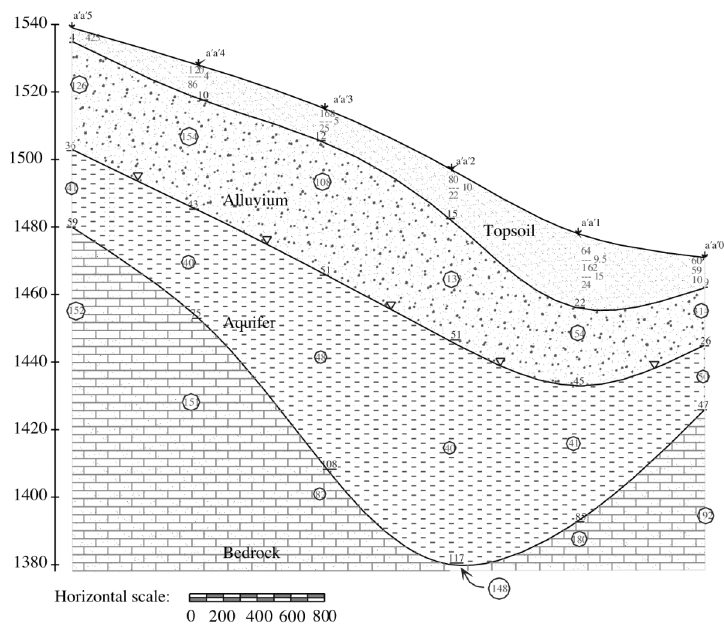
Fig. 4. Geoelectrical section of profile aa l .